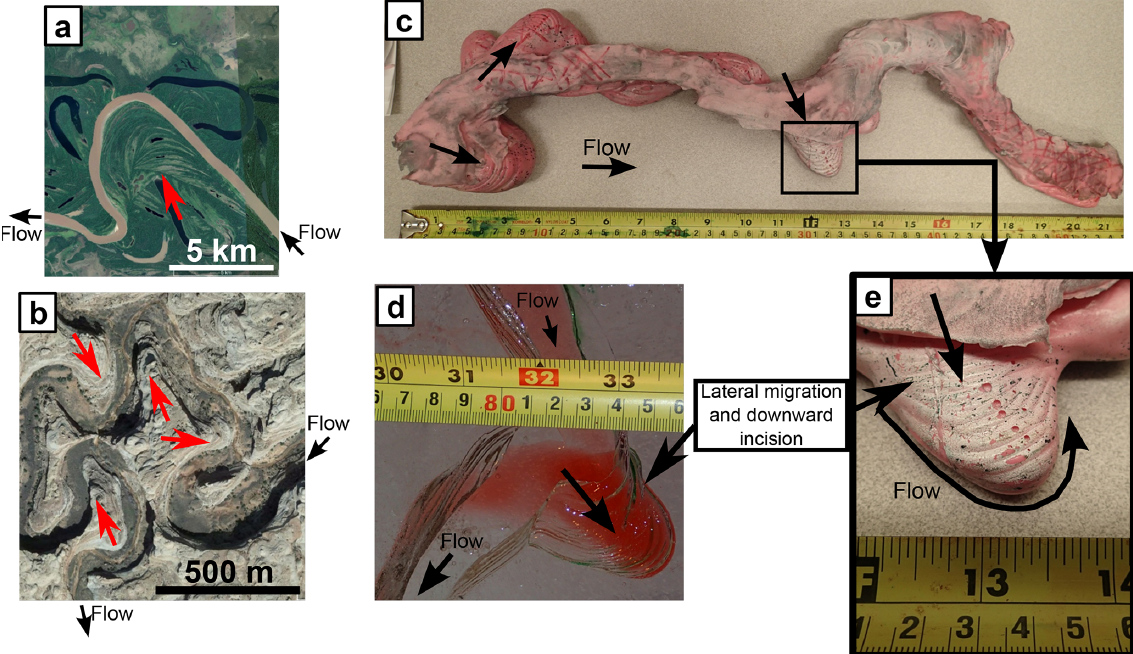
Figure 5. Pulsed lateral migration features indicated by arrows in (a) an alluvial river (scroll bars), (b) a bedrock river, (c) the rubber mold of a meltwater laboratory channel, (d) a meltwater laboratory channel, and (e) a close-up of the bend in the rubber mold region indicated in (c) . Image information: (a) Mamore river, Beni, Bolivia; Location: 255863.55E, 8514710.26S; Source: © Google Earth 2020. (b) Tributary of the San Juan River; bedrock river in the Mogollon Rim, Utah, USA; Location: 574447.88E, 4141533.73N; Source: © Google Earth 2020. (c–e) Source: this